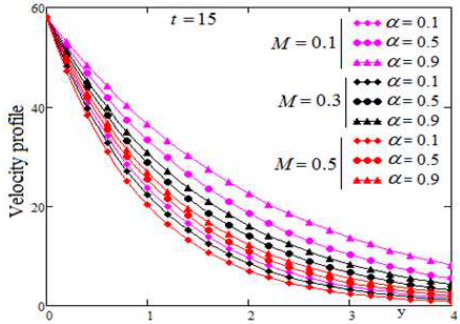
Figure 4. Profile of dimensionless velocity versus y for α variation with Pr = 0 . 7 , S = 5 , Sc = 0 . 8 , λ = 4 , Gr = 3 , Gm = 0 . 9 , and different values of M for large